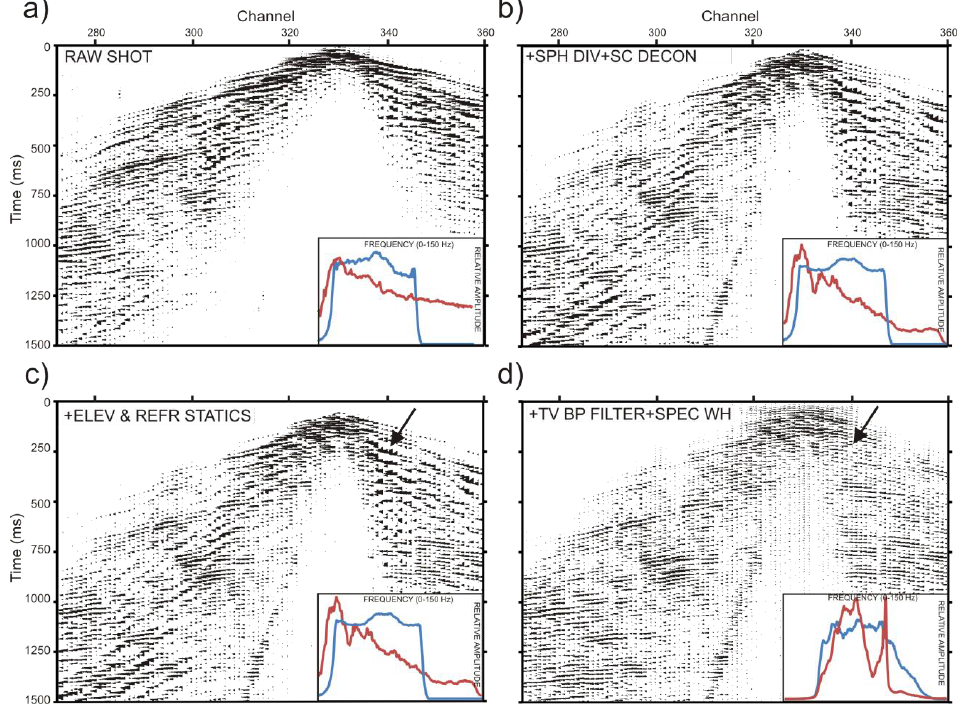
Fig. 7. Closeup of the shot gather 1820 (see also Fig. 3) after different steps in the data processing: (a) raw shot; (b) same as (a) plus spherical divergence and surface consistent deconvolution; (c) same as (b) plus elevation and refraction statics; and (d) same as (c) plus time-variant frequency filter and spectral whitening. Each plot also contains a frequency spectrum graph (similar to that of Fig. 4) comparing the amplitudes and frequencies of the shot 1820 (Vibroseis source, dark grey) and 1158 (explosive source, light grey). Note that frequency graphs are shown only for qualitative comparison (values of the frequency graphs are the same as in Fig. 4, not shown here for display purposes).